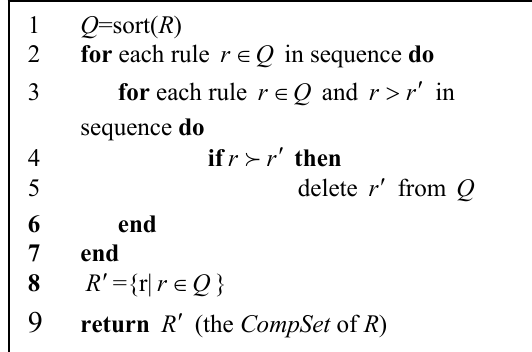
Fig. 2: Algorithm